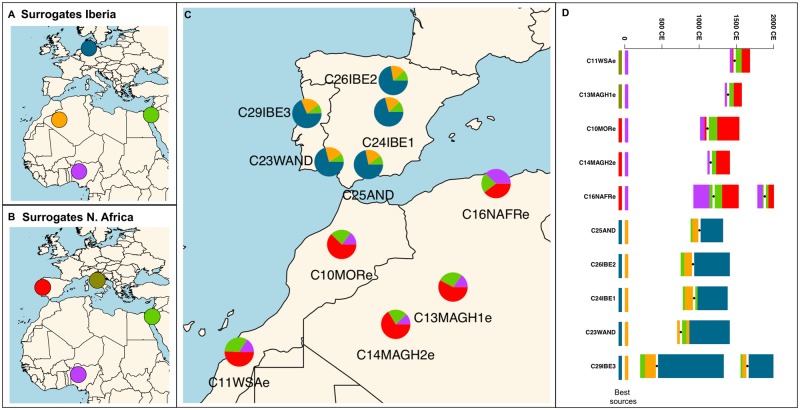
GLOBETROTTER results. (A) Surrogates for the Iberian recipient clusters. (B) Surrogates for the North African recipient clusters. (C) Admixture proportions inferred from a nonnegative least squares approach. (D) GLOBETROTTER results for each cluster. Black points show the mean admixture dates (calculated as 2,000−25×generation time). Barplot colors show the source populations that contributed to the admixture (see A and B). Bar width represents the bootstrap 100% CI. Best sources are indicated in the left.